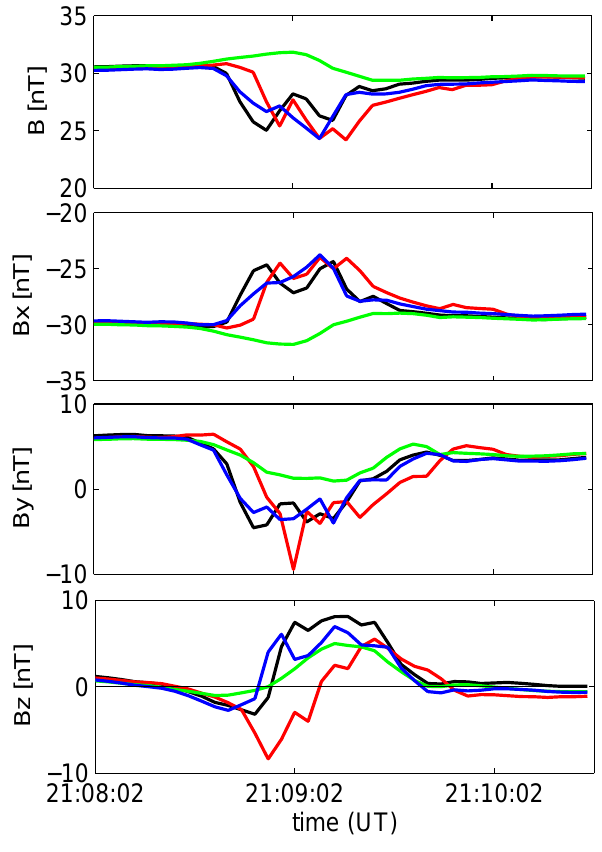
Fig. 4. TCR2: Total magnetic field B , and B x , B y , and B z for the second TCR. The different behavior of C1 (black), C2 (red), C4 (blue) data on the one hand and C3 (green) data on the other hand is due to the location of the first mentioned spacecraft inside the plasma bulge and C3 outside.